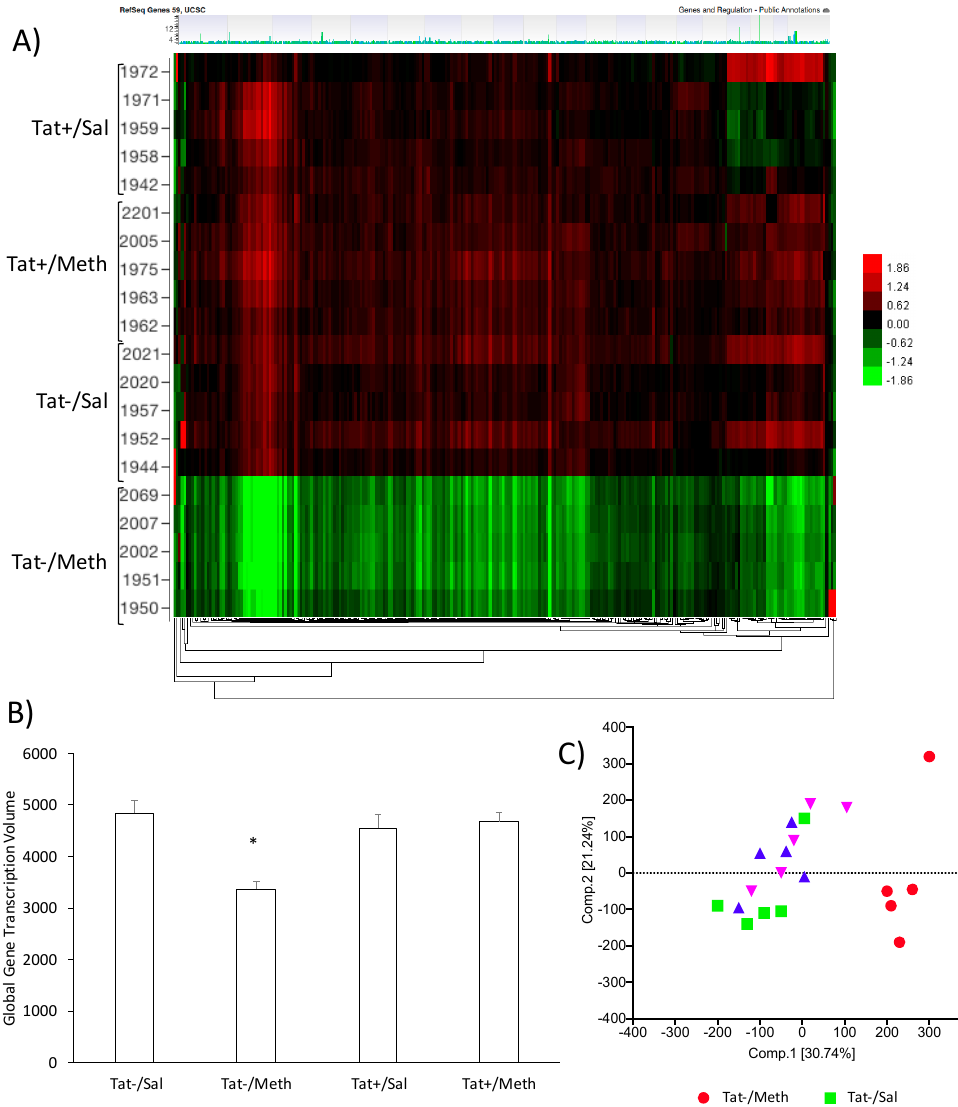
Figure 1. The effects of Methamphetamine (Meth) and trans-activator of transcription (Tat) expression on transcriptional activity in the brain. ( A ) Heat map clustering of gene signatures generated between Tat − and Tat+ mice sensitized with Meth or saline (Sal) prior to the Meth challenge. The caudate-putamen tissue was evaluated for gene expression using an Agilent mouse gene array platform. The heat map shows patterns of expression normalized to the average expression of all the data. Horizontal rows represent individual animals, clustered in groups, Tat+/Sal, Tat+/Meth, Tat − /Sal, and Tat − /Meth. The numbers refer to each individual mouse identification. Vertically, genes are arranged in clusters according to change patterns between groups. Expression values are represented in colors according to the levels of upregulation (red shades), downregulation (green shades), or no change (black); ( B ) Global transcriptional volume calculated using the sum of all up- and downregulated fold changes group averaged for each group condition; ( C ) Principal component analysis (PCA) scores for individual animals. PCA was performed using Tat expression and sensitization for quality control and to summarize the ways in which gene responses vary under Tat, Meth, or their interaction.